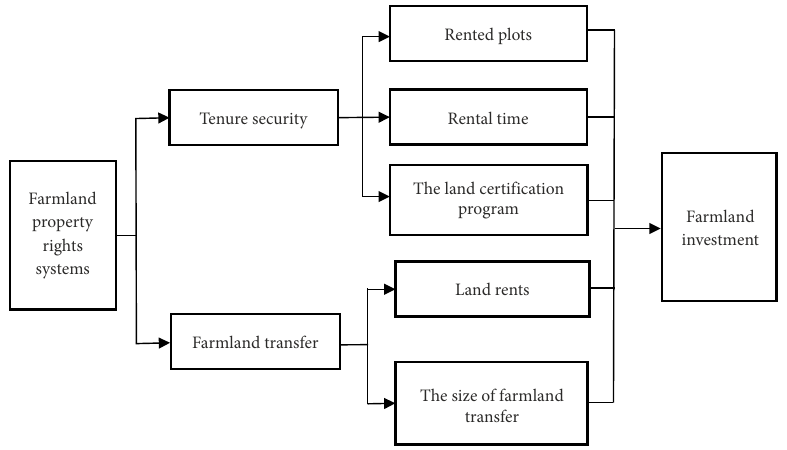
Figure 1. Conceptual